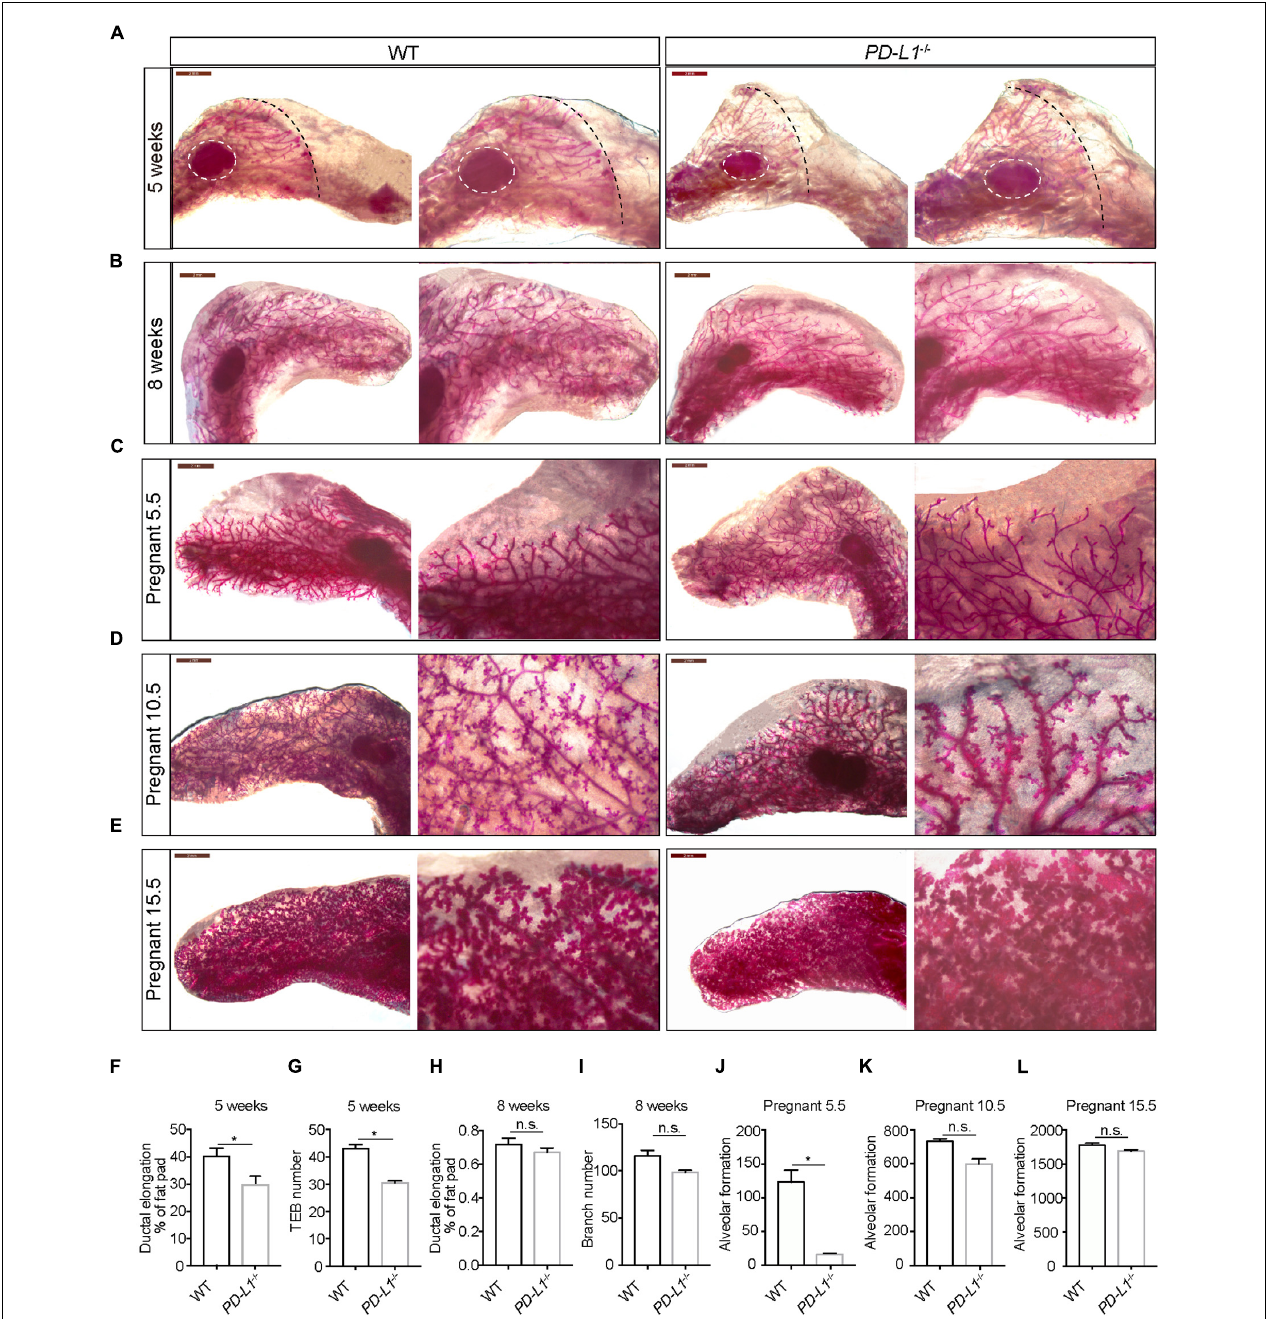
FIGURE 4 | PD-L1 deficiency impairs mammary gland development during puberty and pregnancy. (A–E) Whole-mount imaging (carmine staining) of the mammary epithelium at 5 weeks (A) , 8 weeks (B) , early pregnancy (Day 5.5) (C) , middle pregnancy (Day 10.5) (D) , and late pregnancy (Day 15.5) (E) of wild-type (WT) and PD-L1 − / − (homozygous, PD-L1 deficiency) mice. Scale bars, 2 mm; n = 3 mice. (F) Quantification of ductal elongation in 5-week-old WT and PD-L1 − / − mice. Data are presented as mean ± SD. Unpaired t -test: * P < 0.05. (G) Quantification of terminal end bud (TEB) number in 5-week-old WT and PD-L1 − / − mice. Data are presented as mean ± SD. Unpaired t -test: * P < 0.05. (H) Quantification of ductal elongation in 8-week-old WT and PD-L1 − / − mice. Data are presented as mean ± SD. Unpaired t -test: n.s., not significant. (I) Quantification of branch number in 8-week-old WT and PD-L1 − / − mice. Data are presented as mean ± SD. Unpaired t -test: n.s., not significant. (J) Quantification of alveolar formation in early pregnant WT and PD-L1 − / − mice. Data are presented as mean ± SD. Unpaired t -test: * P < 0.05. (K) Quantification of alveolar formation in middle pregnant WT and PD-L1 − / − mice. Data are presented as mean ± SD. Unpaired t -test: n.s., not significant. (L) Quantification of alveolar formation in late pregnant WT and PD-L1 − / − mice. Data are presented as mean ± SD. n.s., not significant; n = 5 mice. Both ductal elongation and TEB formation at puberty are reduced in PD-L1 − / − mice; alveolar formation in early pregnancy is also impaired in PD-L1 − / − mice. PD-L1, programmed cell death ligand